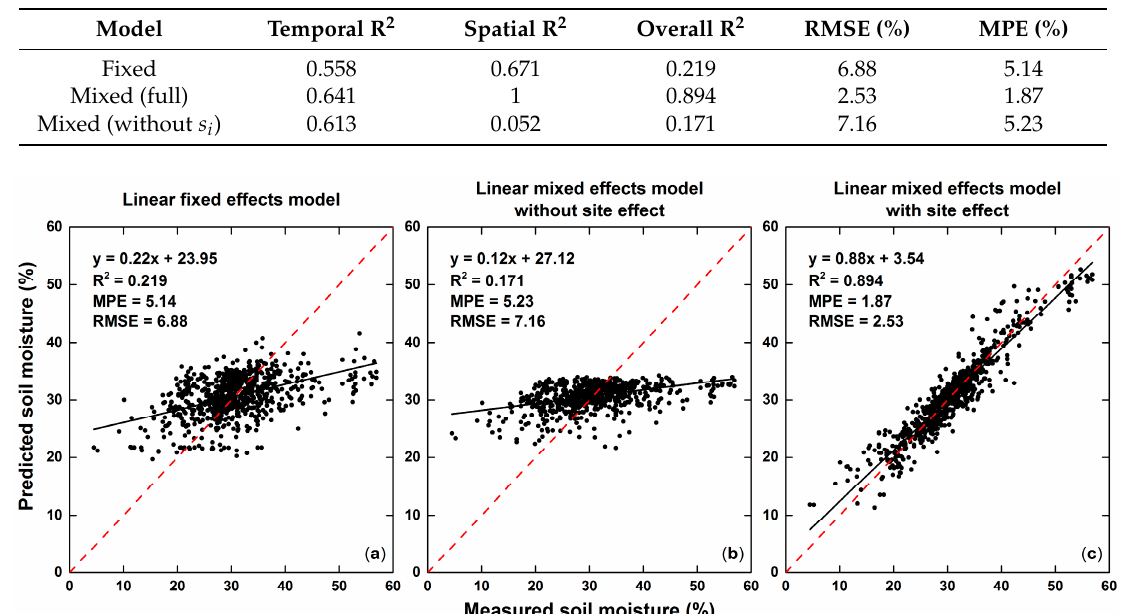
Figure 2. Scatter plots of measured versus predicted soil moisture from ( a ) the linear fixed effects model; ( b ) the mixed effects model without site effect; and ( c ) the mixed effects model with site effect. The solid black line and dashed red line represent the regression line and 1:1 line, respectively.